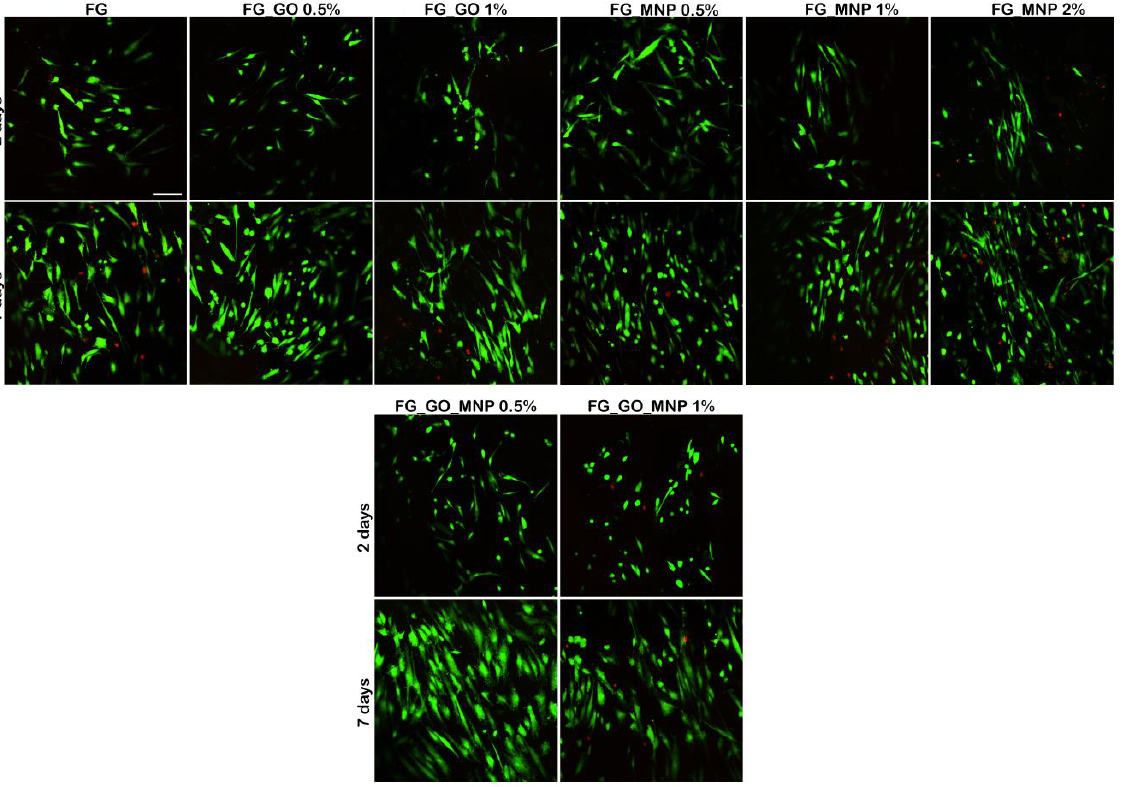
Figure 6. Biocompatibility evaluation of FG meshes in contact with human adipose-derived stem cells. Live/Dead staining on gelatin scaffolds shown through confocal microscopy: live cells are labeled in green fluorescence with calcein AM and the nuclei of dead cells is labeled in red with ethidium bromide. Scale bar = 50 µm.